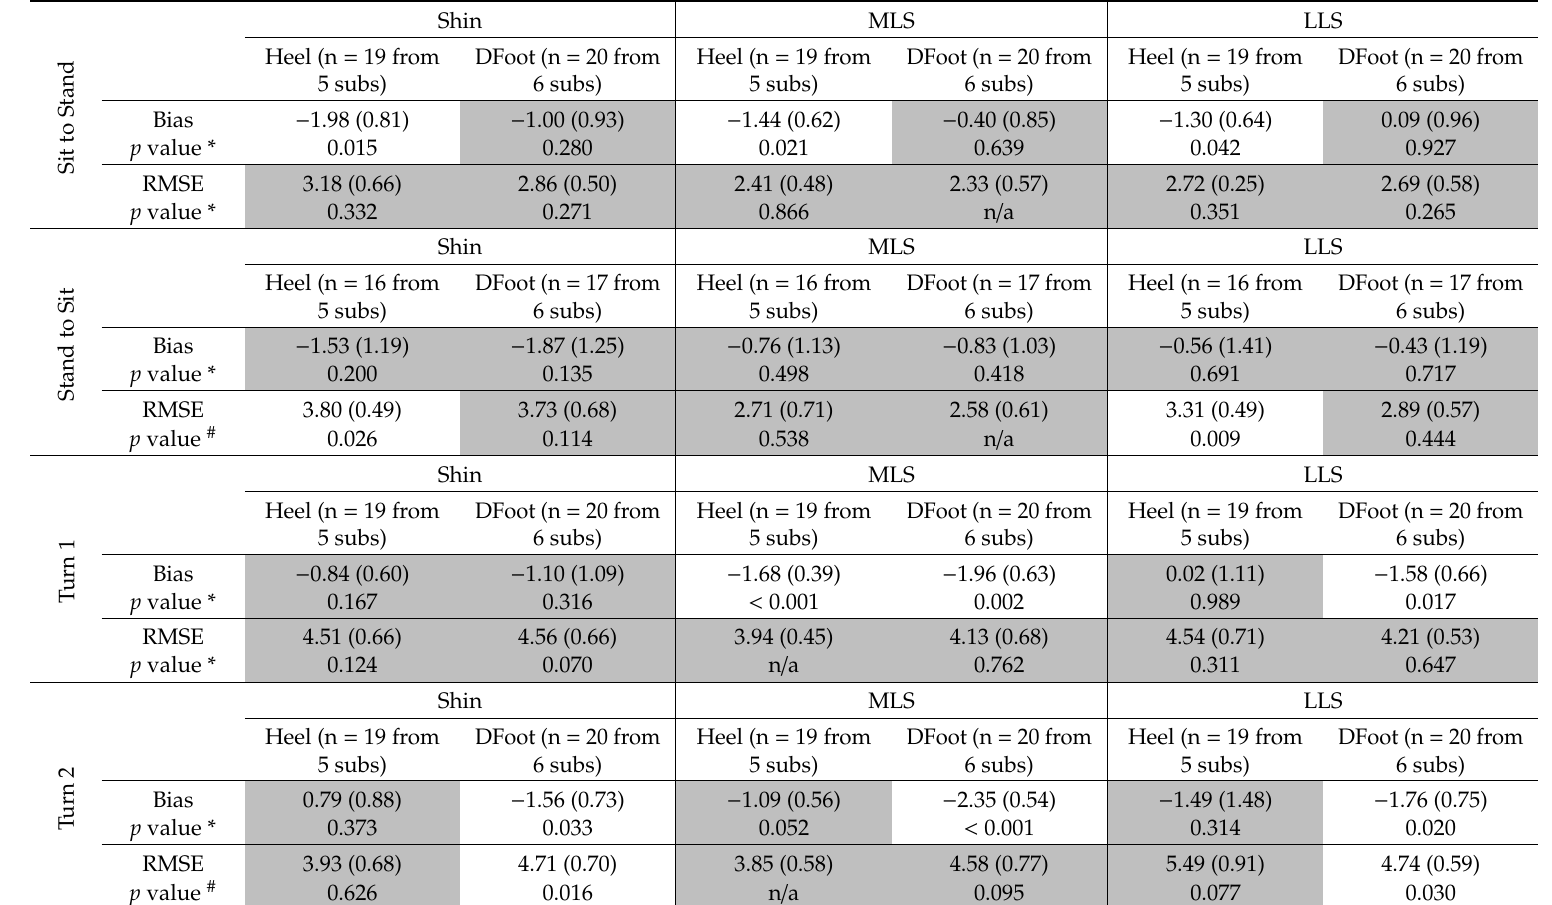
Table 4. Ankle flexion bias and RMSE [least squares mean (standard error)] for each sensor combination versus gold standard MOCAP